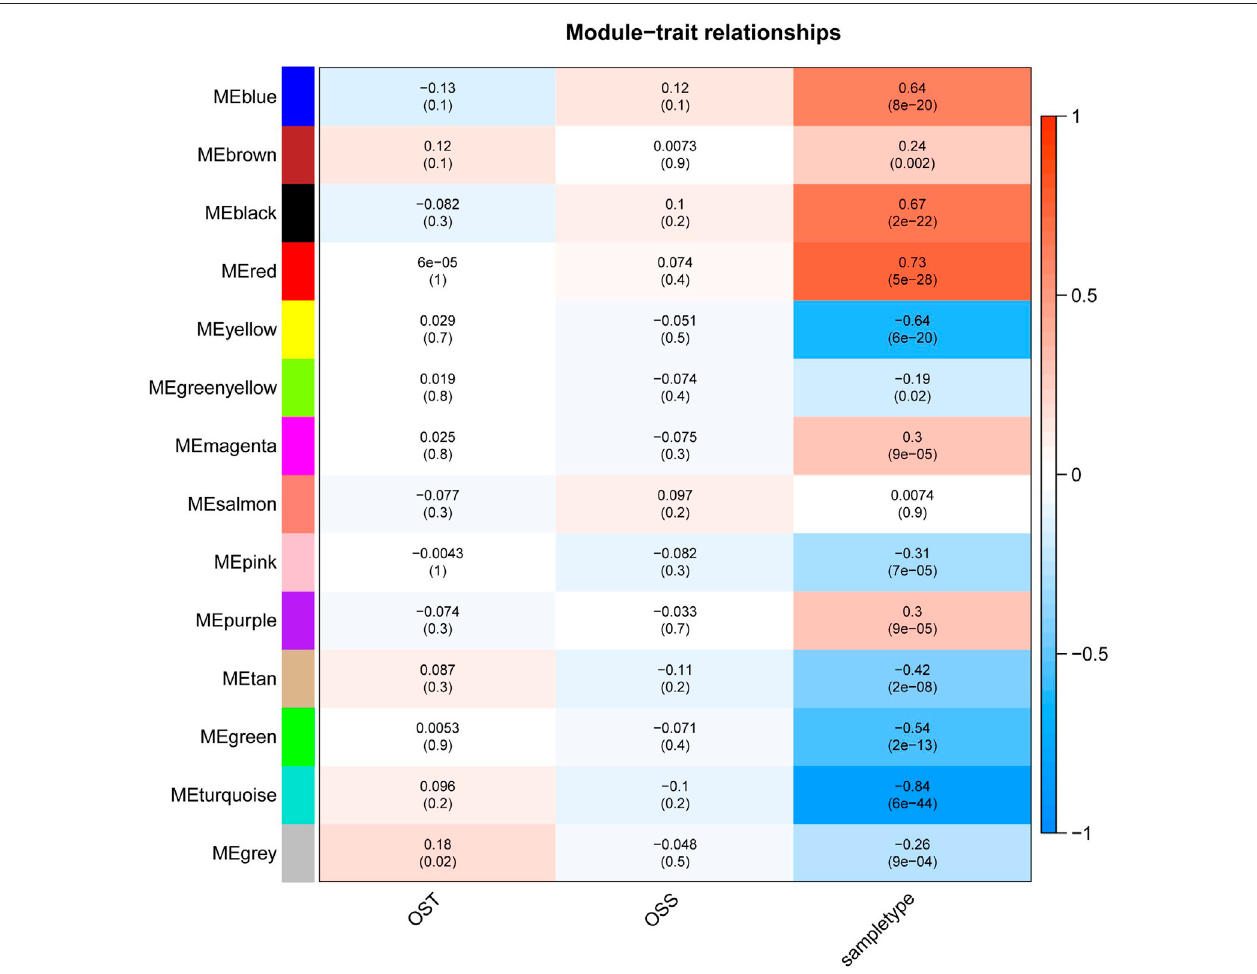
FIGURE 3 | Heatmap of the relationship between module eigengenes and clinical traits of GSE66229. WGCNA labeled heatmaps for GSE66229, each row represents a module characteristic gene encoded by color, and the three columns represent clinical characteristics of overall survival time (OST), overall survival status (OSS),and sample type, respectively. Each cell represents thePearson correlation coef fi cient and p -value(in parentheses) ofthe correspondingmodule characteristics, and the color of each cell represents the value of correlation.